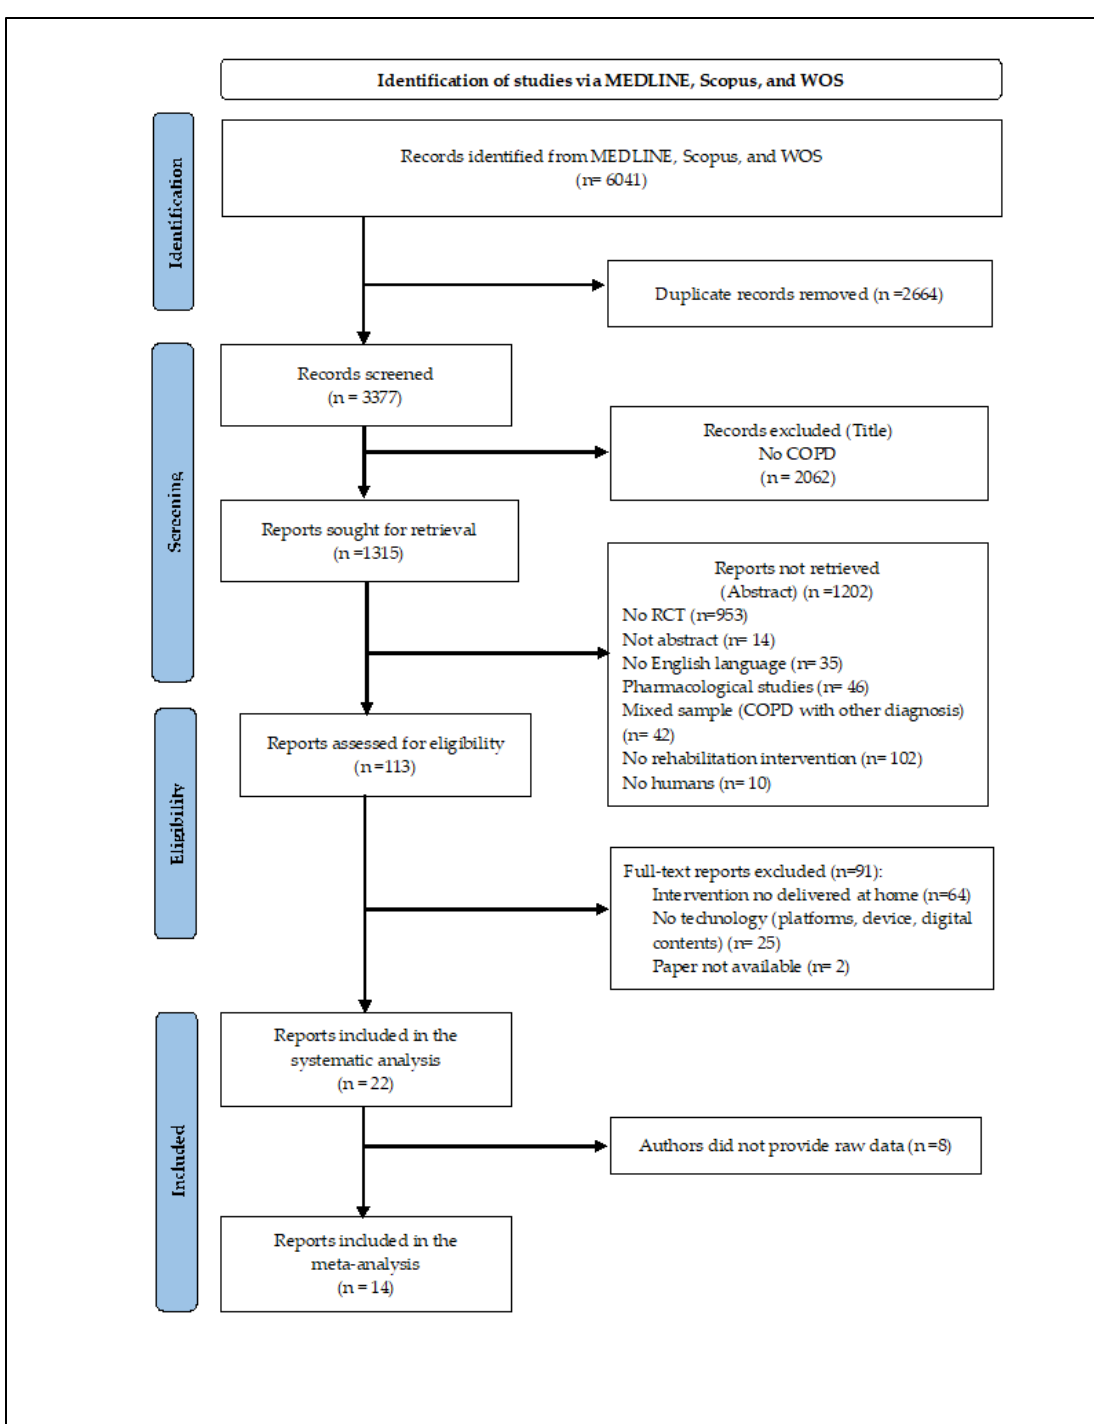
Figure 1. 2020 PRISMA Flow Diagram.